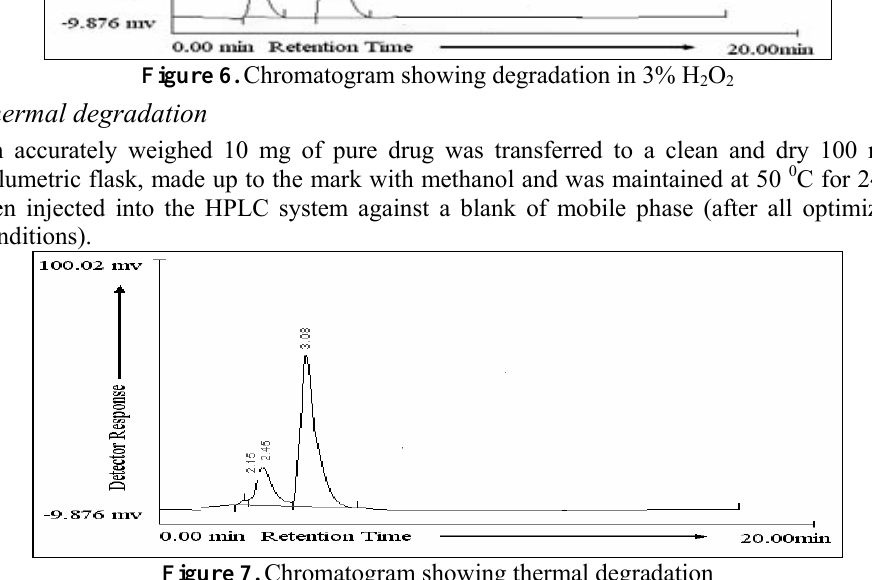
Figure 6. Chromatogram showing degradation in 3% H